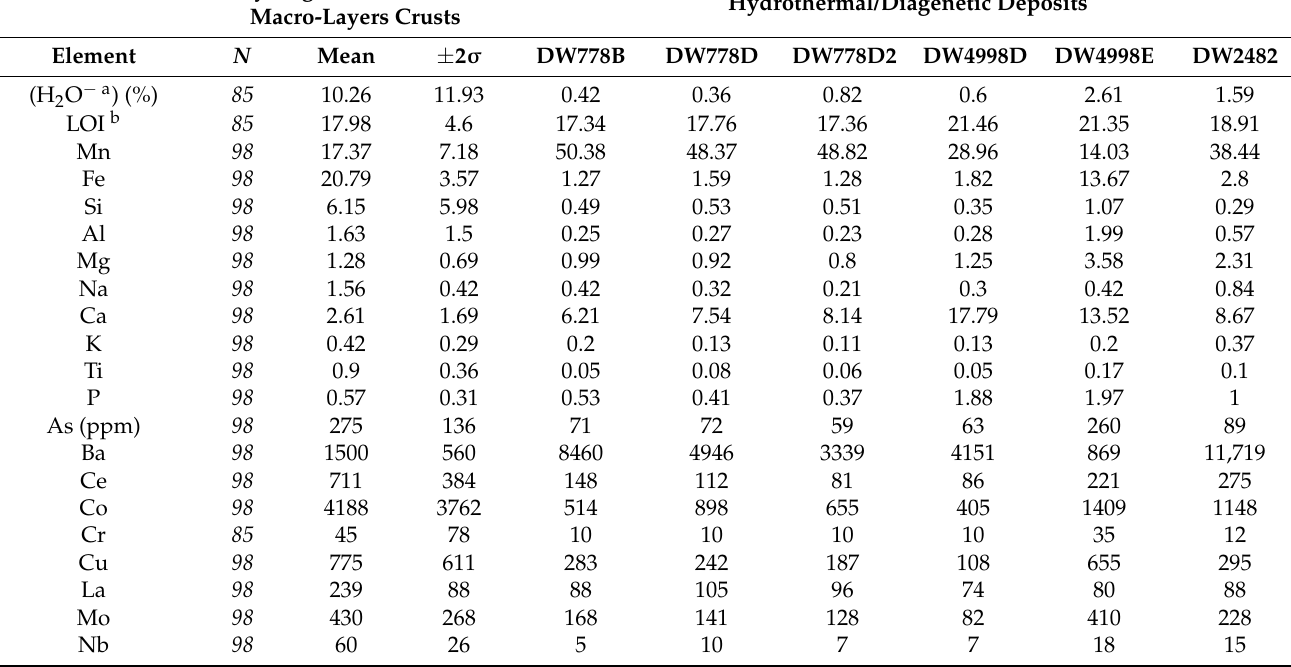
Table 3. Statistics for the geochemical data sets normalised to 0% H 2 O −